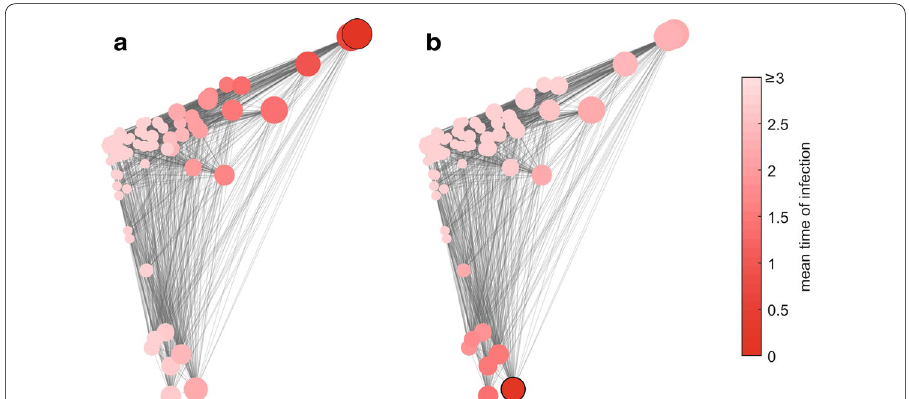
Fig. 2 Simulated initial spread of disease from key nodes in a hospital ward contact network. A black outline defines the initially infected node in a , b . The mean time to infection, from 100 SI simulations ( τ = 1 ), is differentiated by colour for values below 3. Connections between nodes are also